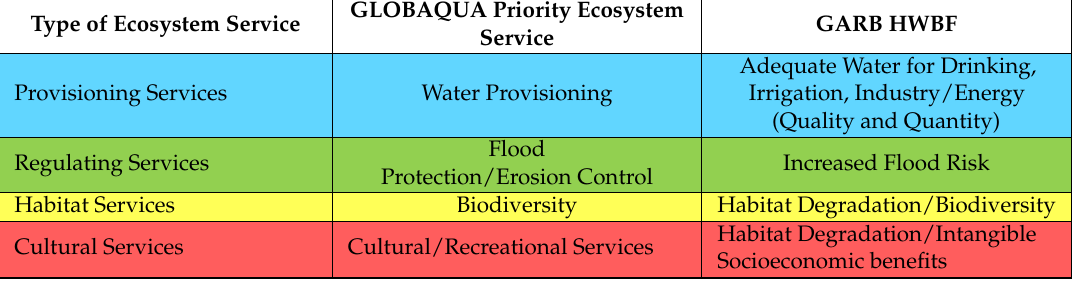
Table 2. Deriving GLOBAQUA River Basins (GARB) Human Wellbeing factors ( Note: Each ES Type Denoted by a different